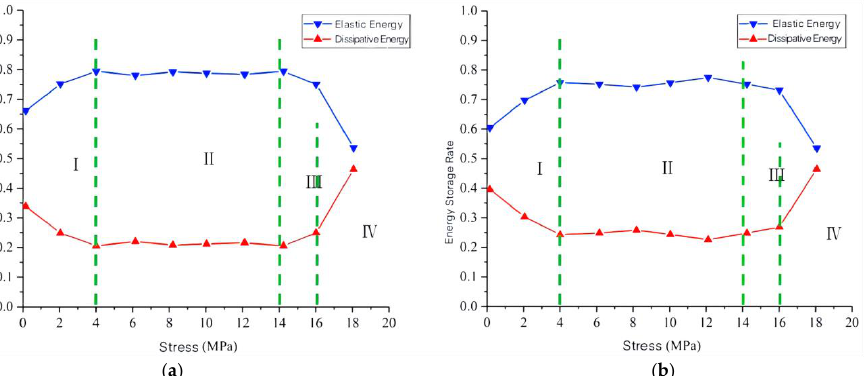
Figure 7. The energy storage rate evolution under staged cyclic loading/unloading. The green line is used to delineate the different stages through which the coal samples in the diagram have gone. ( a ) Variation curves of elastic energy storage rate and energy dissipation rate of coal sample S1. ( b ) Variation curves of elastic energy storage rate and energy dissipation rate of coal sample S2.